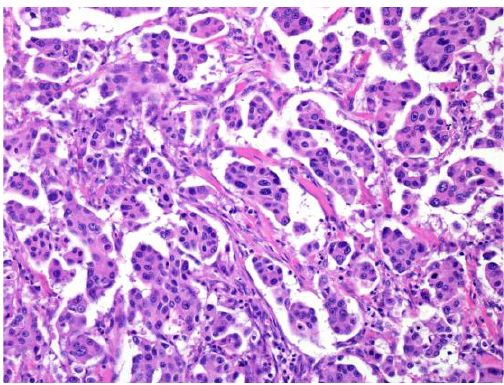
Figure 2. Micropapillary salivary duct carcinoma (SDC). The tumor forms many micropapillary nests that consist of eosinophilic cytoplasm and irregular nuclear-like